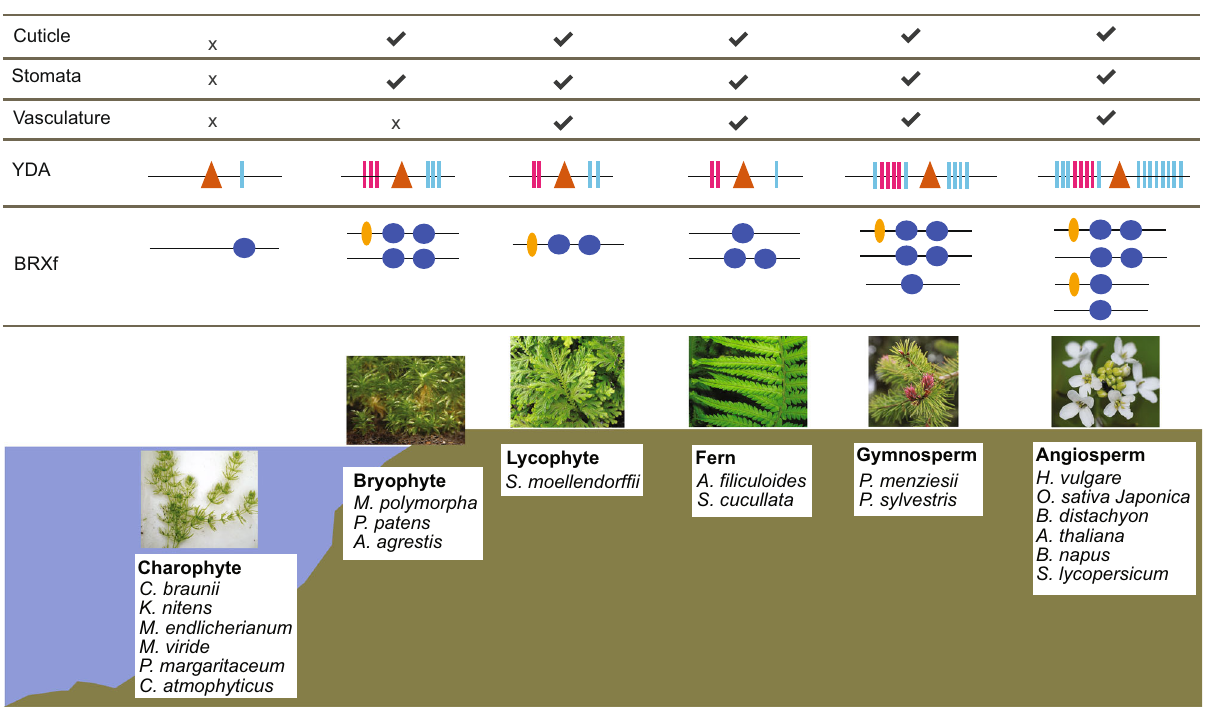
Fig.6|YDAmotifandBRXdomaincontainingproteinsappeartogetherinland plants. “ X ” and “ ✔ ” indicatetheabsenceandpresence,respectively,ofeachfeature indifferentplantclasses.ProteinmodelsofYDAmotifandBRX-domaincontaining proteins summarised based on compositions of representative species in Supple- mentaryFigs.12and13.Representativepicturesandthescienti fi